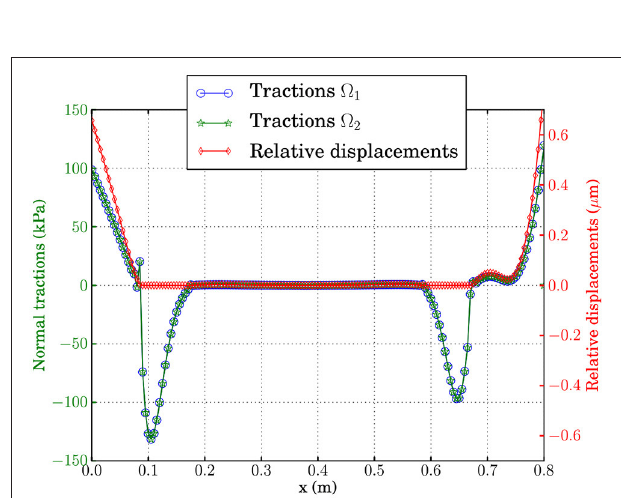
FIGURE 19 | Force F y predicted by both methods as a function of the imposed vertical displacement u D .